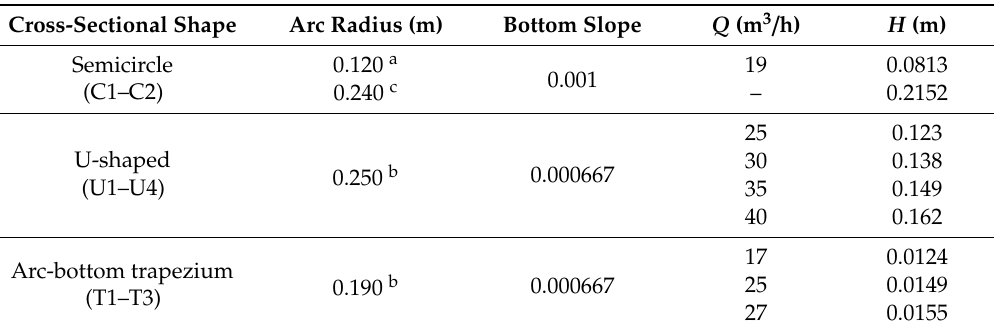
Table 1. Summary of experimental